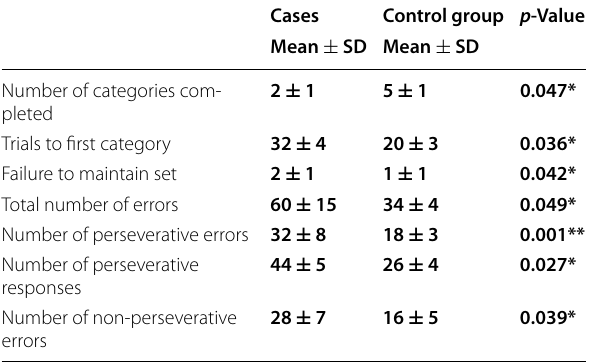
Table 2 Comparison between cases and control